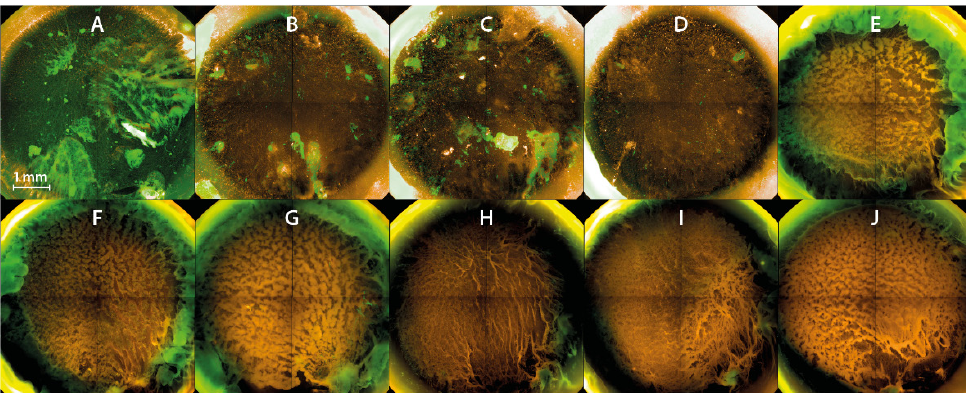
Figure 4. The images show inverse footage of the biofilms. The pretreatment time defines the time period in which the water came into contact with the plasma gas. The post-treatment time represents the period of time where the PTW came into contact with the biofilm. The biofilms are stained with SYTO9 (green) for living cells and propidium iodide (red) for dead cells. ( A ) Control biofilm ( B ) 100 s pretreatment, 1 min post-treatment ( C ) 100 s pretreatment time, 3 min post-treatment time ( D ) 100 s pretreatment, 5 min post-treatment ( E ) 300 s pretreatment, 1 min post-treatment ( F ) 300 s pretreatment, 3 min post-treatment ( G ) 300 s pretreatment, 5 min post-treatment ( H ) 900 s pretreatment, 1 min